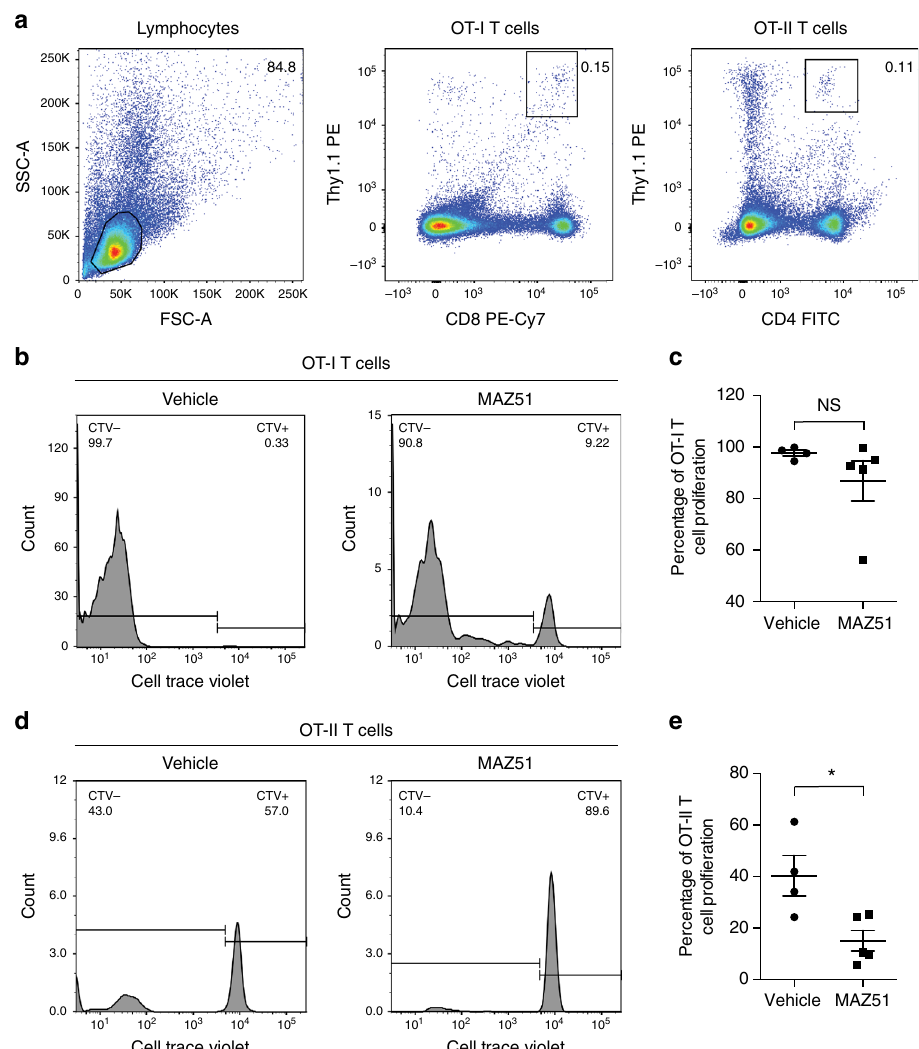
Fig. 6 Inhibition of VEGFR3 reduces CNS antigen-speci fi c CD4 T cell proliferation. a – e ß-gal fl oxed ovalbumin peptides (OP) transgenic mice were crossed with CNP-Cre transgenic mice to drive ovalbumin peptide expression on oligodendrocytes (CNP-OP mice). These mice were then induced with EAE, I.P. treated with either vehicle or the VEGFR3 tyrosine kinase inhibitor MAZ51 beginning on day 7 post-immunization, and ovalbumin-speci fi c CD8 (OT-I) or CD4 (OT-II) Thy1.1 congenic CellTrace Violet labeled T cells were adoptively transferred on day 12 post-immunization. T cell proliferation was then measured by cyto fl uorimetry. a Gating strategy for the adoptively transferred, CellTrace Violet labeled, Thy1.1 congenic, Ovalbumin-speci fi c T cells. b Representative histograms of CellTrace Violet proliferation for OT-I T cells taken from the draining lymph nodes between vehicle and MAZ51 treated EAE animals. c Quantitation of the average percent of OT-I T cell proliferation in the draining lymph nodes at day 18 post-immunization (mean ± SEM; n = 4 – 5 mice per group; NS = non-signi fi cant, unpaired Student ’ s t -test). d Representative histograms of CellTrace Violet proliferation for OT-II T cells taken from the draining lymph nodes between vehicle and MAZ51 treated EAE animals. e Quantitation of the average percent of OT-II T cell proliferation in the draining lymph nodes at day 18 post-immunization (mean ± SEM; n = 4 – 5 mice per group; * p < 0.05, unpaired Student ’ s t (OT-I) and CD4 (OT-II) T cells labeled with CellTrace Violet. On